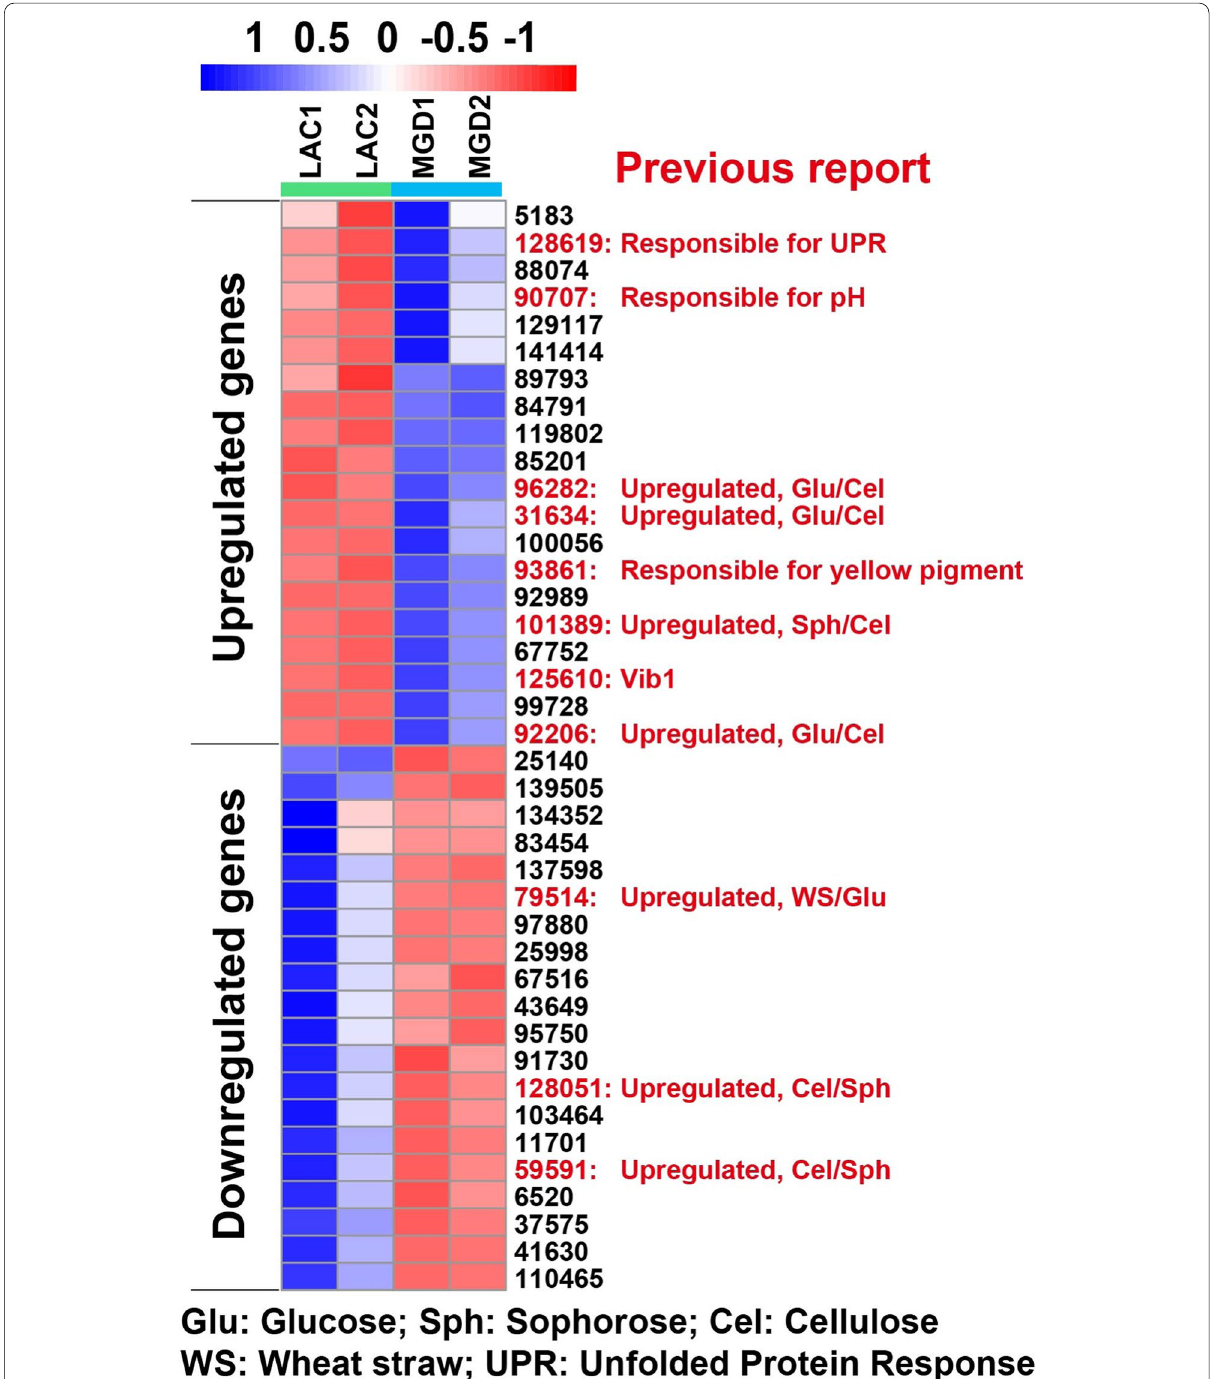
Fig. 3 The top 40 genes of transcription factors that are differentially expressed in MGD or lactose. The columns for LAC1 and LAC2 show the gene expression data using 10 g/L lactose as an inducer at 48 h. The columns for MGD1 and MGD2 show the gene expression data using 10 g/L MGD as an inducer at 36 h. Data are shown as a heat map with the following color code of relative expression values (navy: 1; white: 0; firebrick: numbers indicate the log 2 of the relative expression level). The previously reported transcription factors were